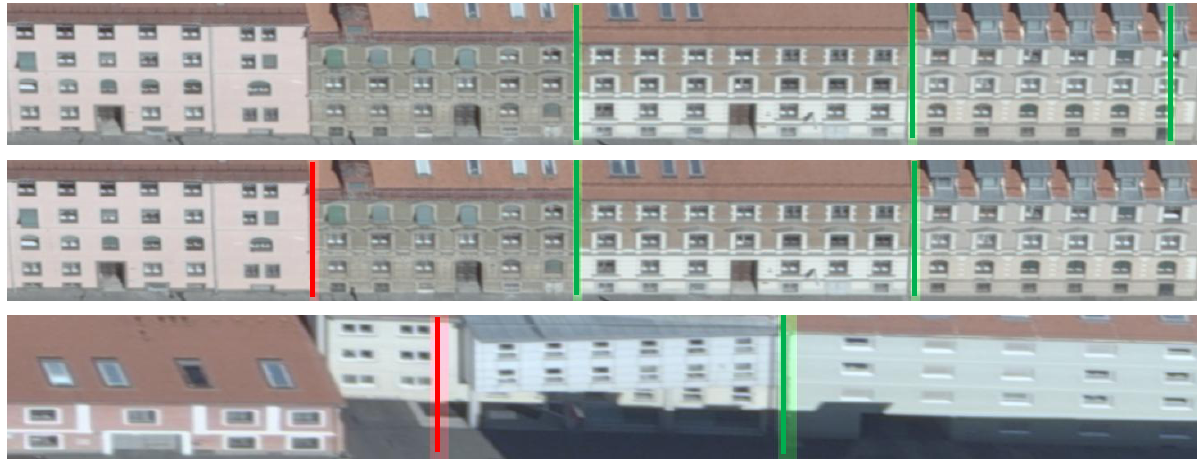
Figure 9: Result of façade separation, red and green lines are detected splits using height and repetitiveness, respectively. (top) without height information, (middle) including height information and (bottom) façade with a false positive (marked in